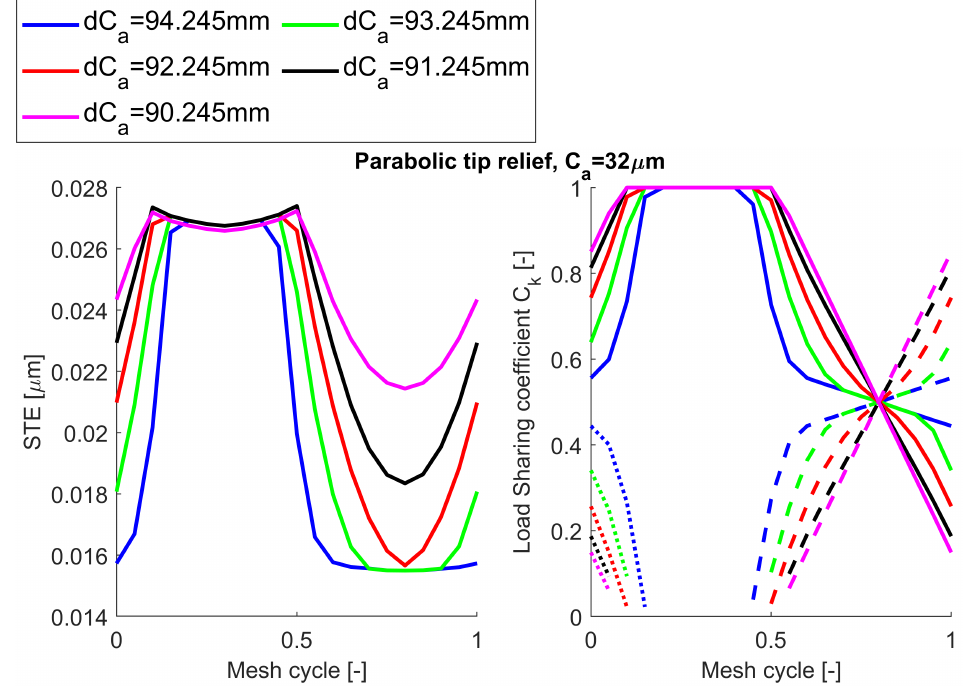
Figure 20. Effect of parabolic tip relief length of modification on the STE and load